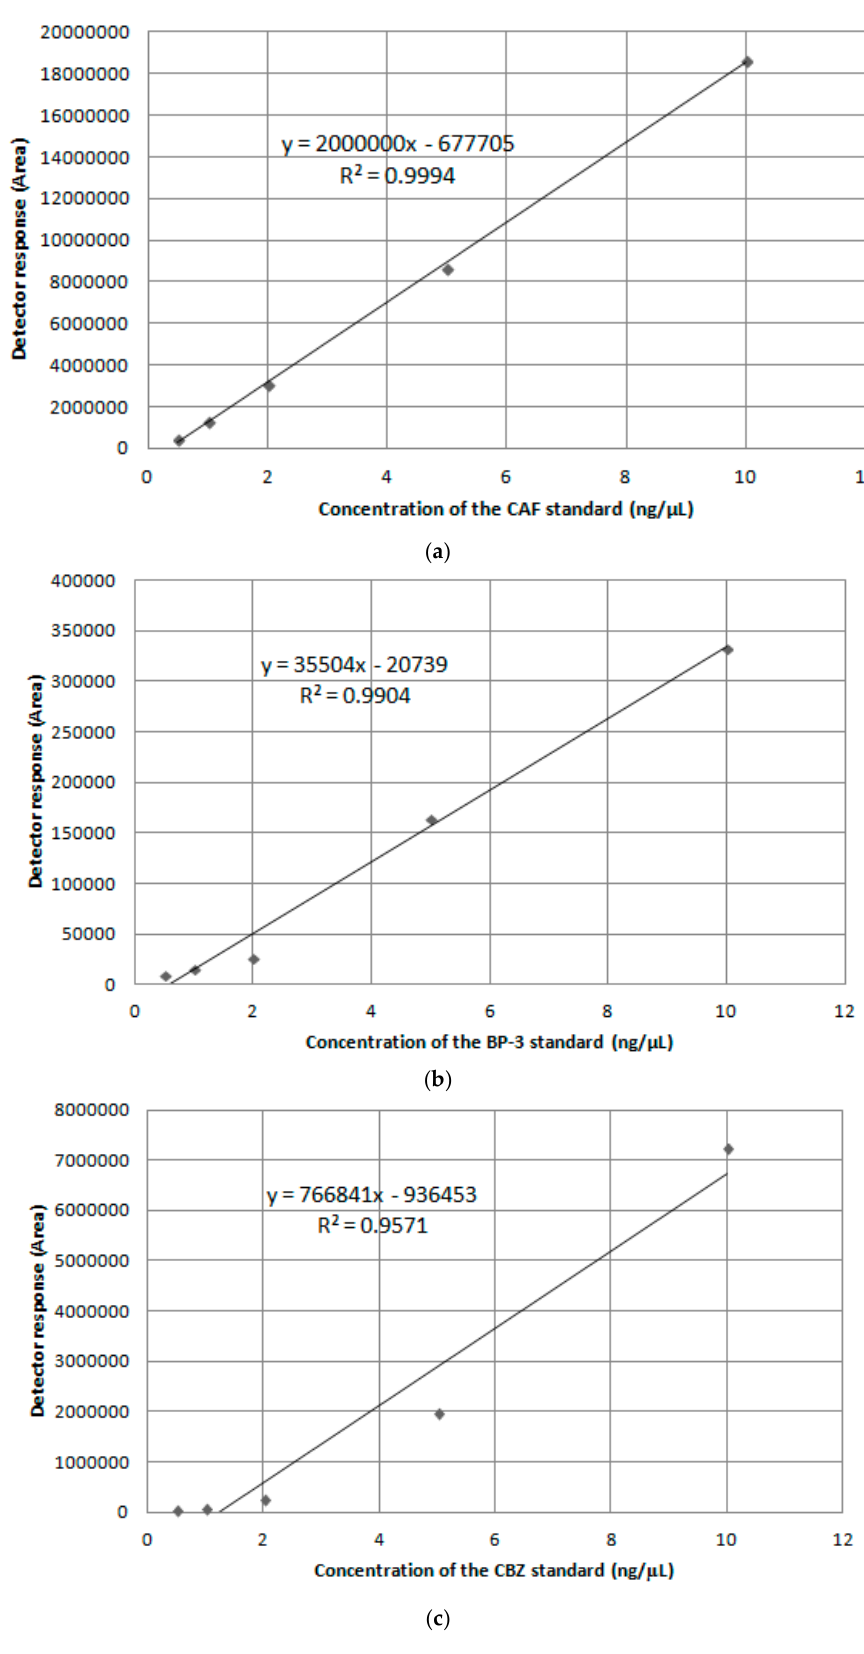
Figure 1. Calibration curve by GC-MS for ( a ) CAF; ( b ) BP-3; ( c )